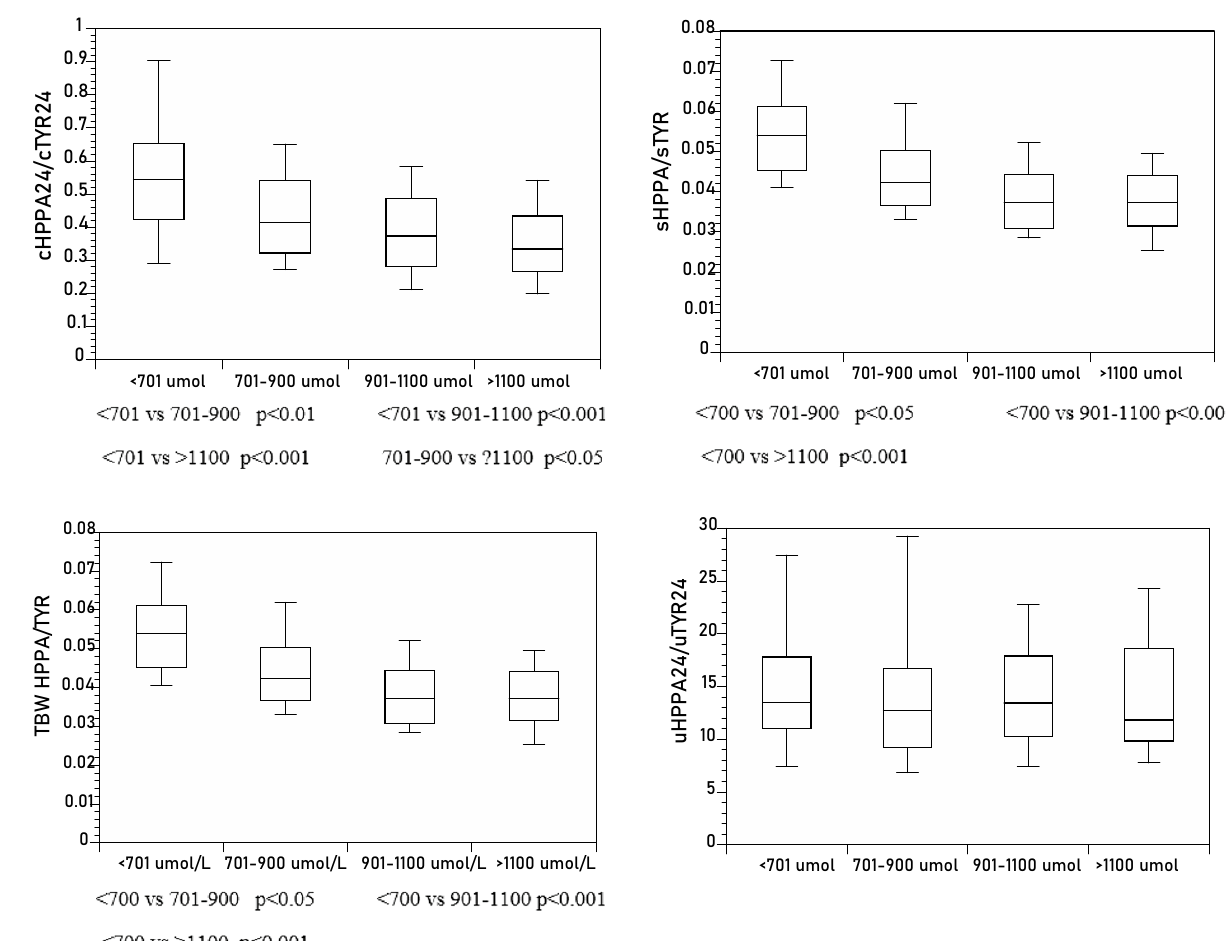
Figure 3. Differences in sHPPA/sTYR, uHPPA 24 /uTYR 24 , tbwHPPA/tbwTYR, and cHPPA 24 /cTYR 24 across the sTYR groups of < 701, 701–900, 901–1100 and > 1100 µmol/L ( p values indicated for within-group comparison where statistical significance was